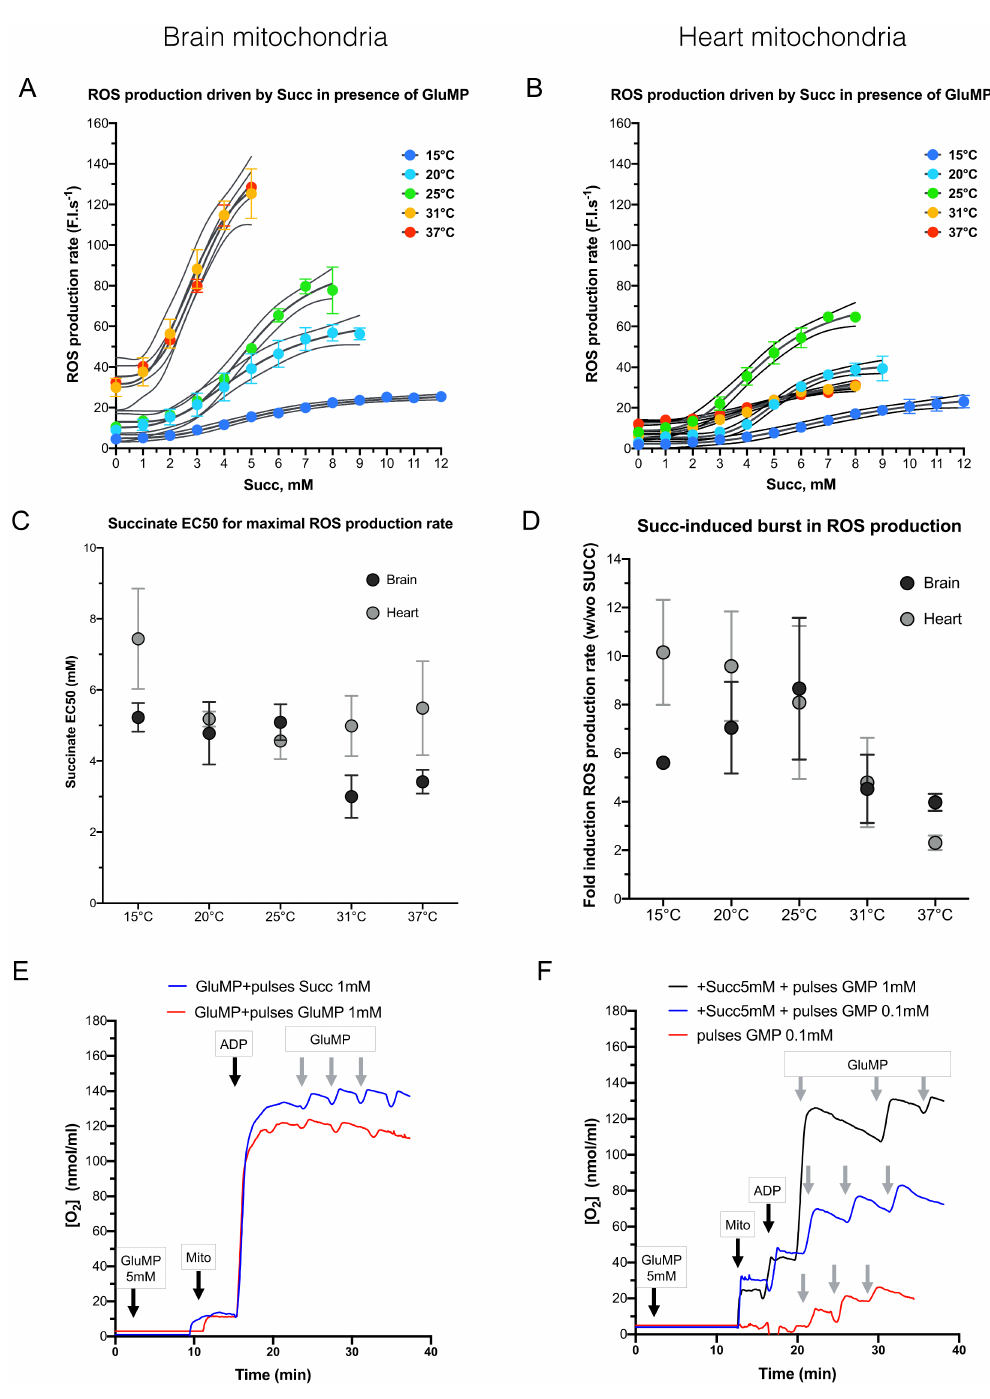
Figure 3. The dependance of mitochondrial ROS production rate on increasing succinate concen- trations. ( A ) ROS production rate in brain mitochondria, in arbitrary fluorescence unit/s (F.I.s − 1 ), according to increasing succinate concentrations at different temperature (15, 20, 25, 31, and 37 ◦ C). For each temperature, each experiment was performed on the same sample in the same cuvette: